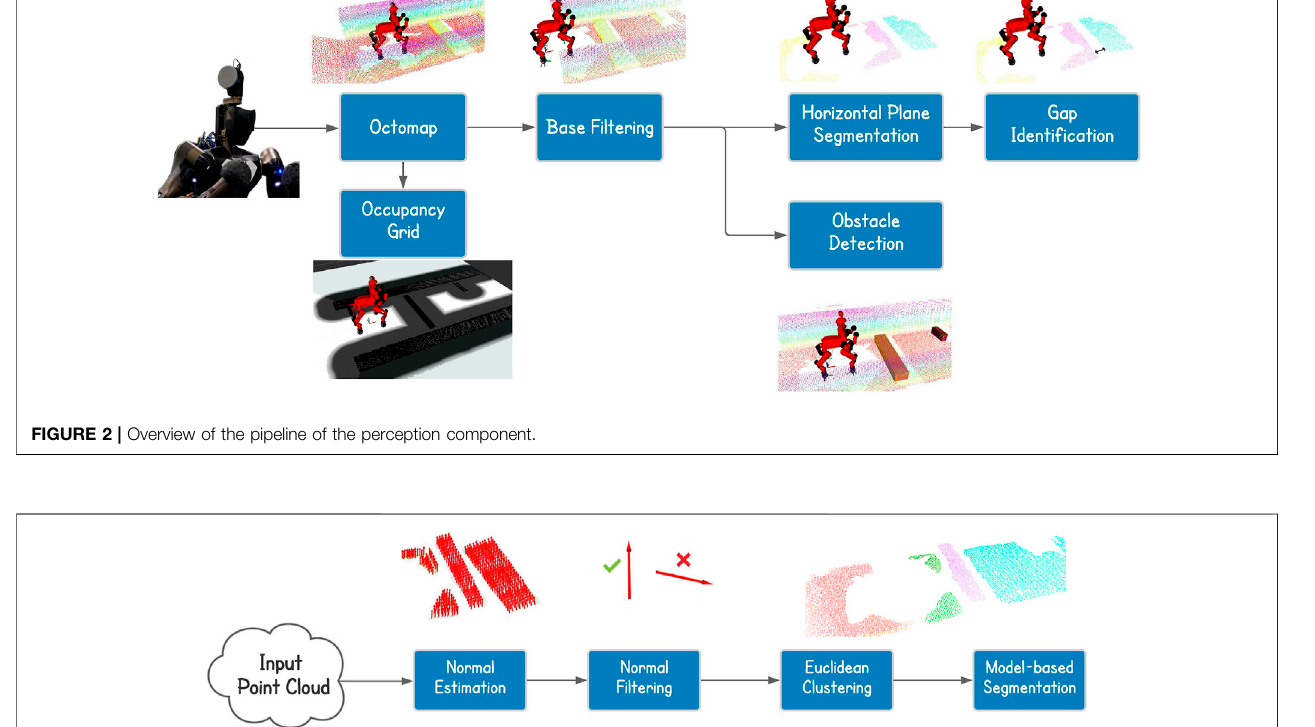
Frontiers in Robotics and AI |